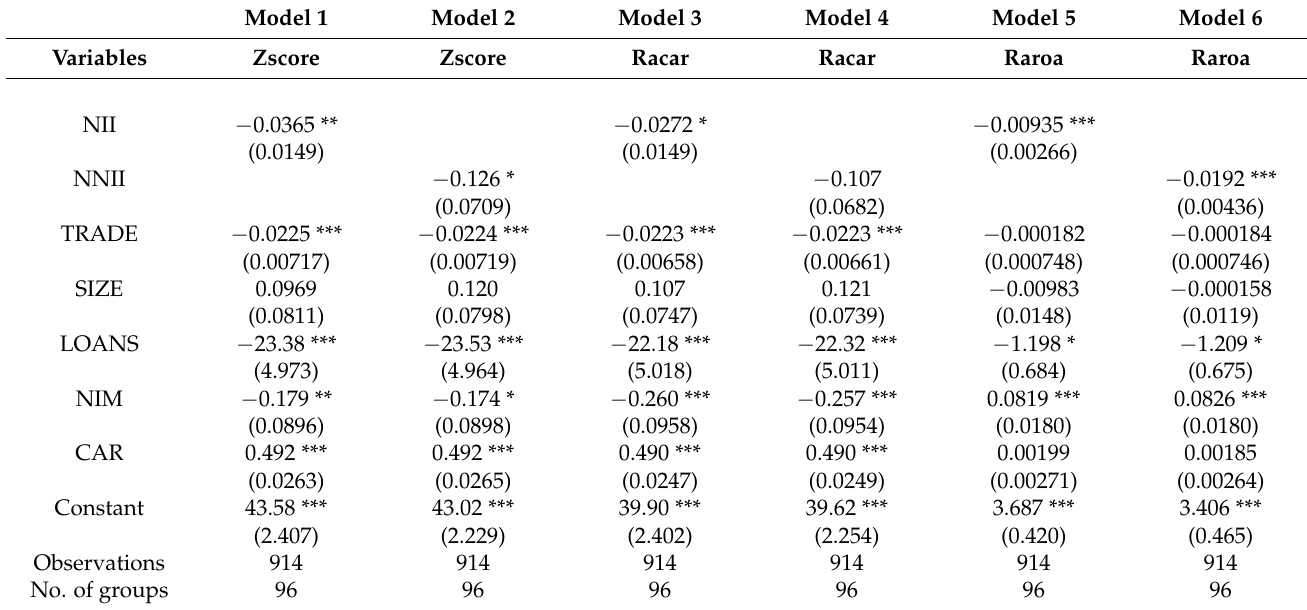
Table 5. Regression results for ASEAN